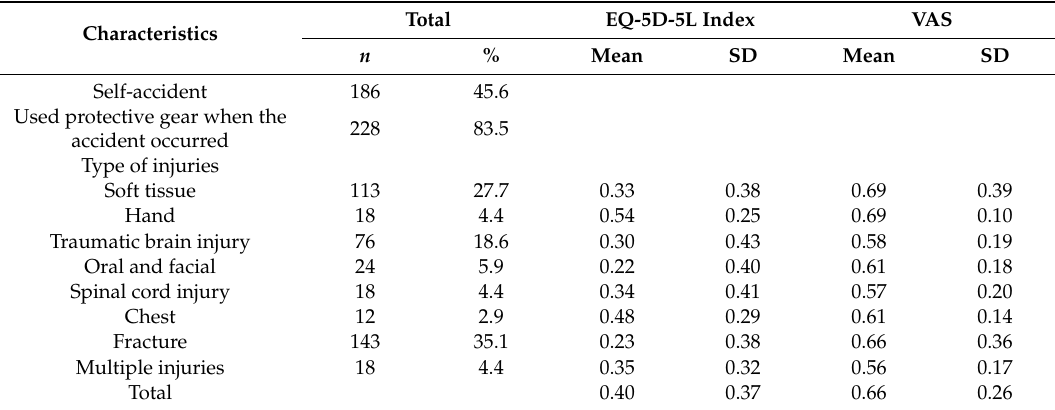
Table 2. Tra ffi c injury characteristics of the participants.